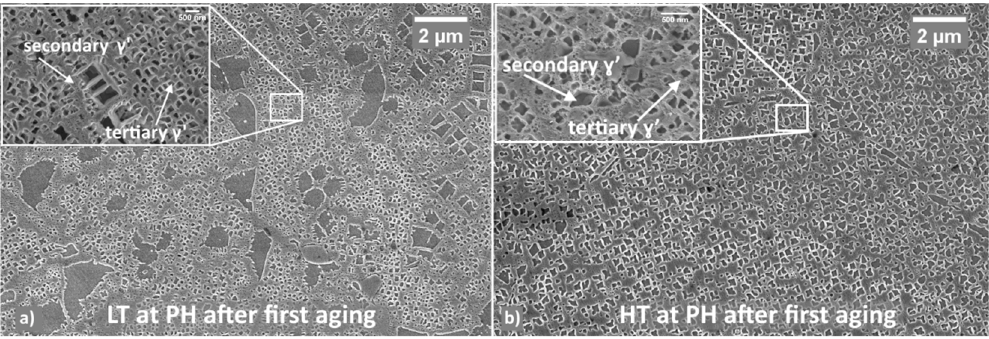
Figure 5. LT sample after aging at 760 °C for 8 h ( a ); HT sample aged at 760 °C for 8 h ( b ).